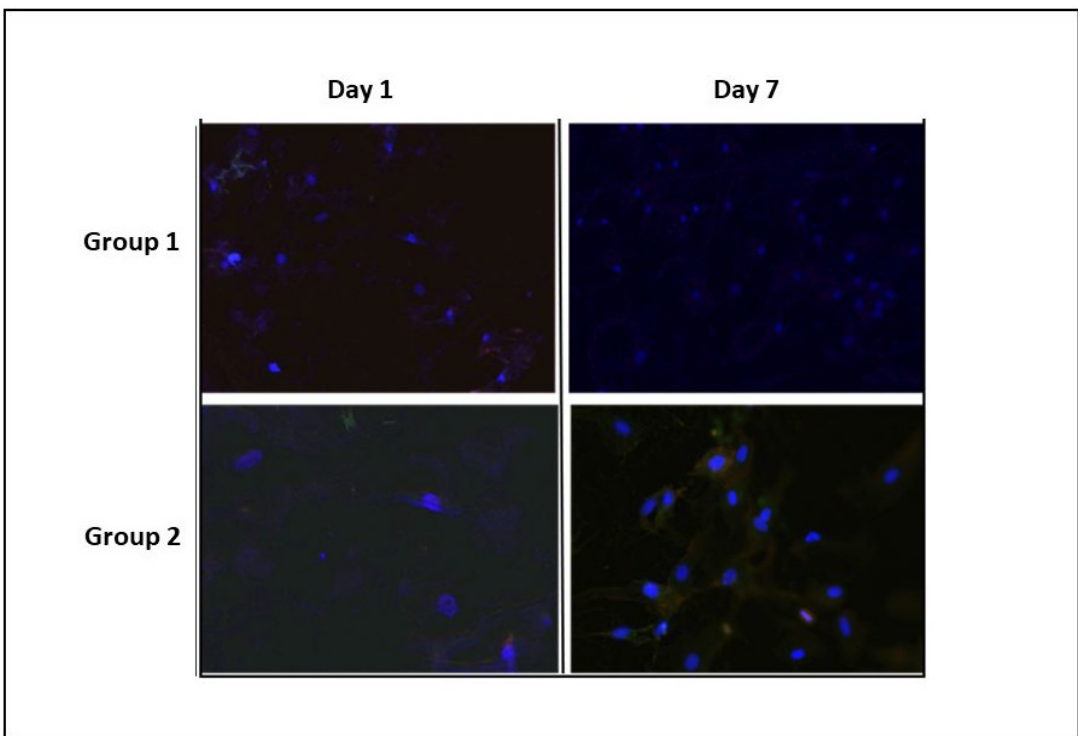
and Group 2 – Nanotubes of TiO 2